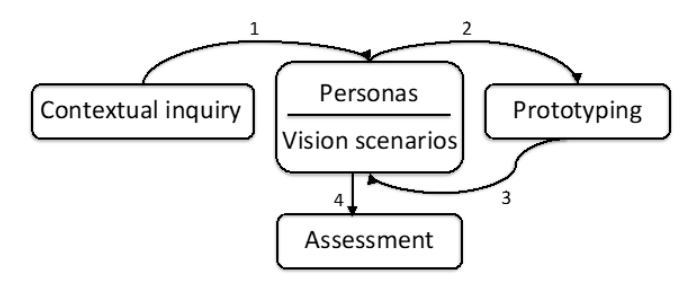
Figure 1. Stages of the followed